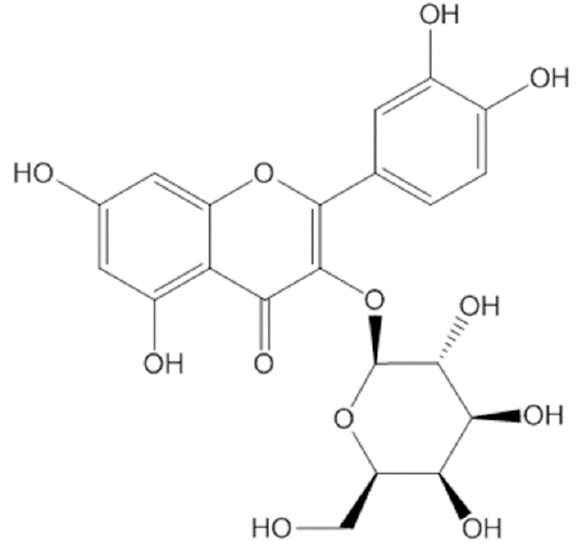
Figure 1. The chemical structure of Hyp.